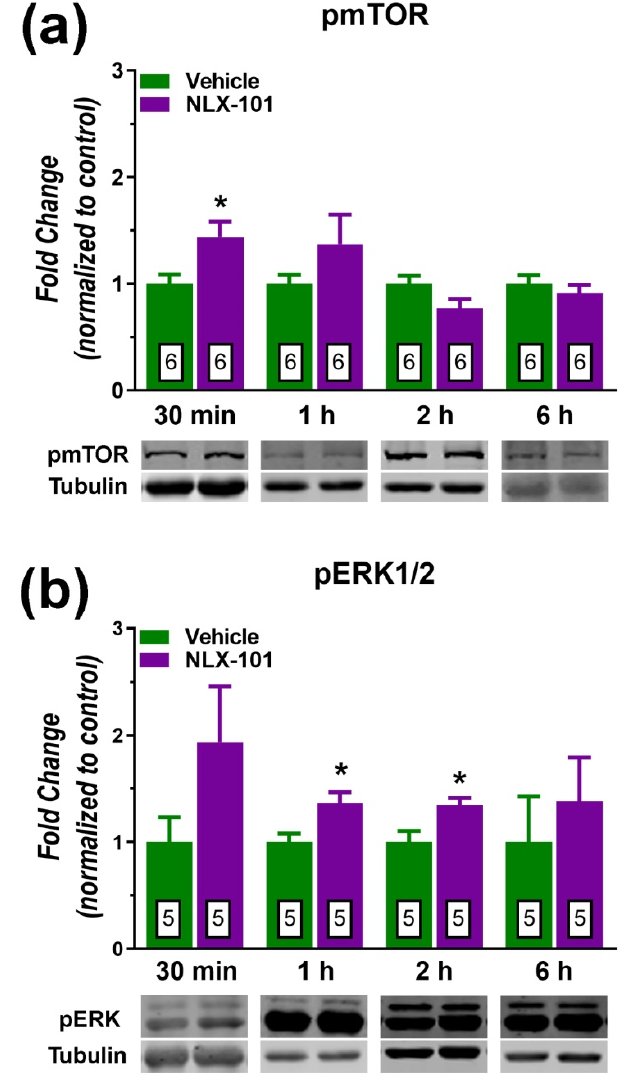
Figure 4. Effects of NLX-101 (0.16 mg/kg) and vehicle (Veh) on the concentration of pmTOR ( a ) and pERK1/2 ( b ) in the prefrontal cortex at 30 min, 1 h, 2 h and 6 h after its intraperitoneal administration. Results are expressed as mean ± SEM. Number of animals is indicated within the bars. * p < 0.05 compared with the corresponding vehicle group (two-tailed Student’s t -test).